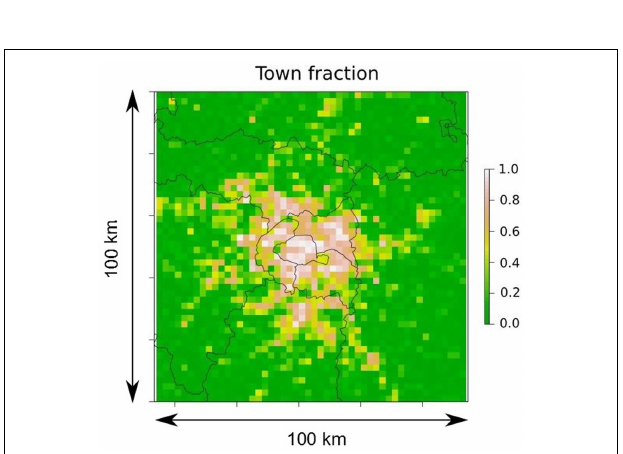
FIGURE 2 | Domain of the simulation, represented by the town fraction. The domain size is 100km by 100km and the grid mesh 2km by